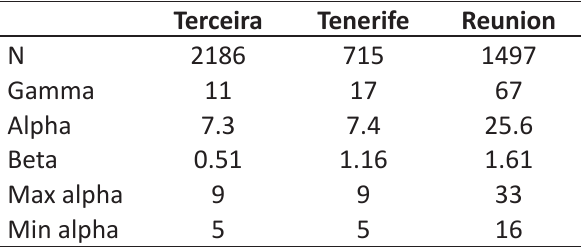
Table 1. Diversity metrics for woody vascular plants for the three study islands: Terceira (Azores), Tenerife (Canaries), and Reunion (Mascarene Islands). Gamma